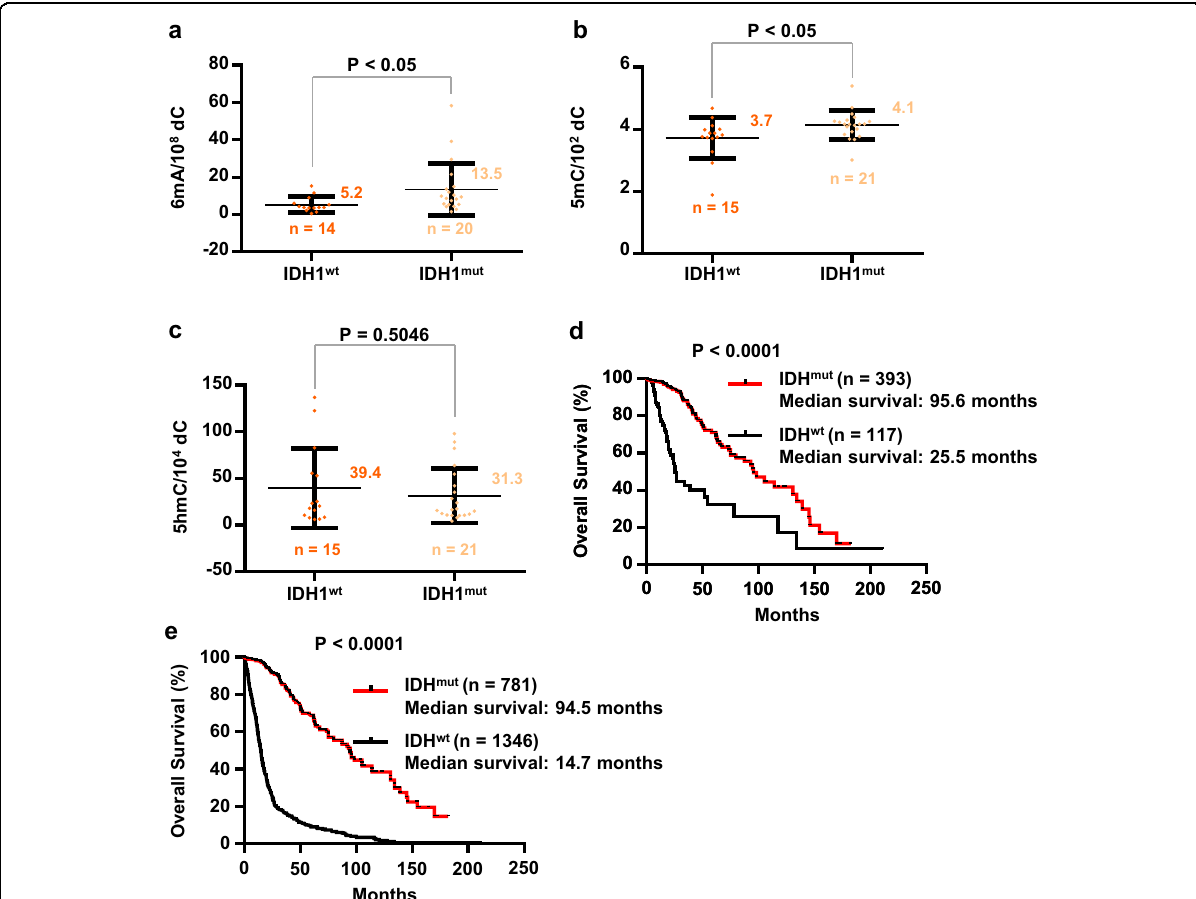
Fig. 4 Increase of DNA 6mA and 5 mC in IDH1-mutant gliomas (glioblastoma excluded). a DNA 6mA content in IDH1 wt and IDH1 mut glioma tissues. IDH1 wt , n = 14; IDH1 mut , n = 20. b , c DNA 5mC ( b ) or 5hmC ( c ) content in IDH1 wt and IDH1 mut glioma tissues. IDH1 wt , n = 15; IDH1 mut , n = 21. c Kaplan – Meier curve of Low-Grade glioma patients ’ survival. Patients were strati fi ed into the “ IDH1 mut ” group ( n = 393) and the “ IDH1 wt ” group ( n